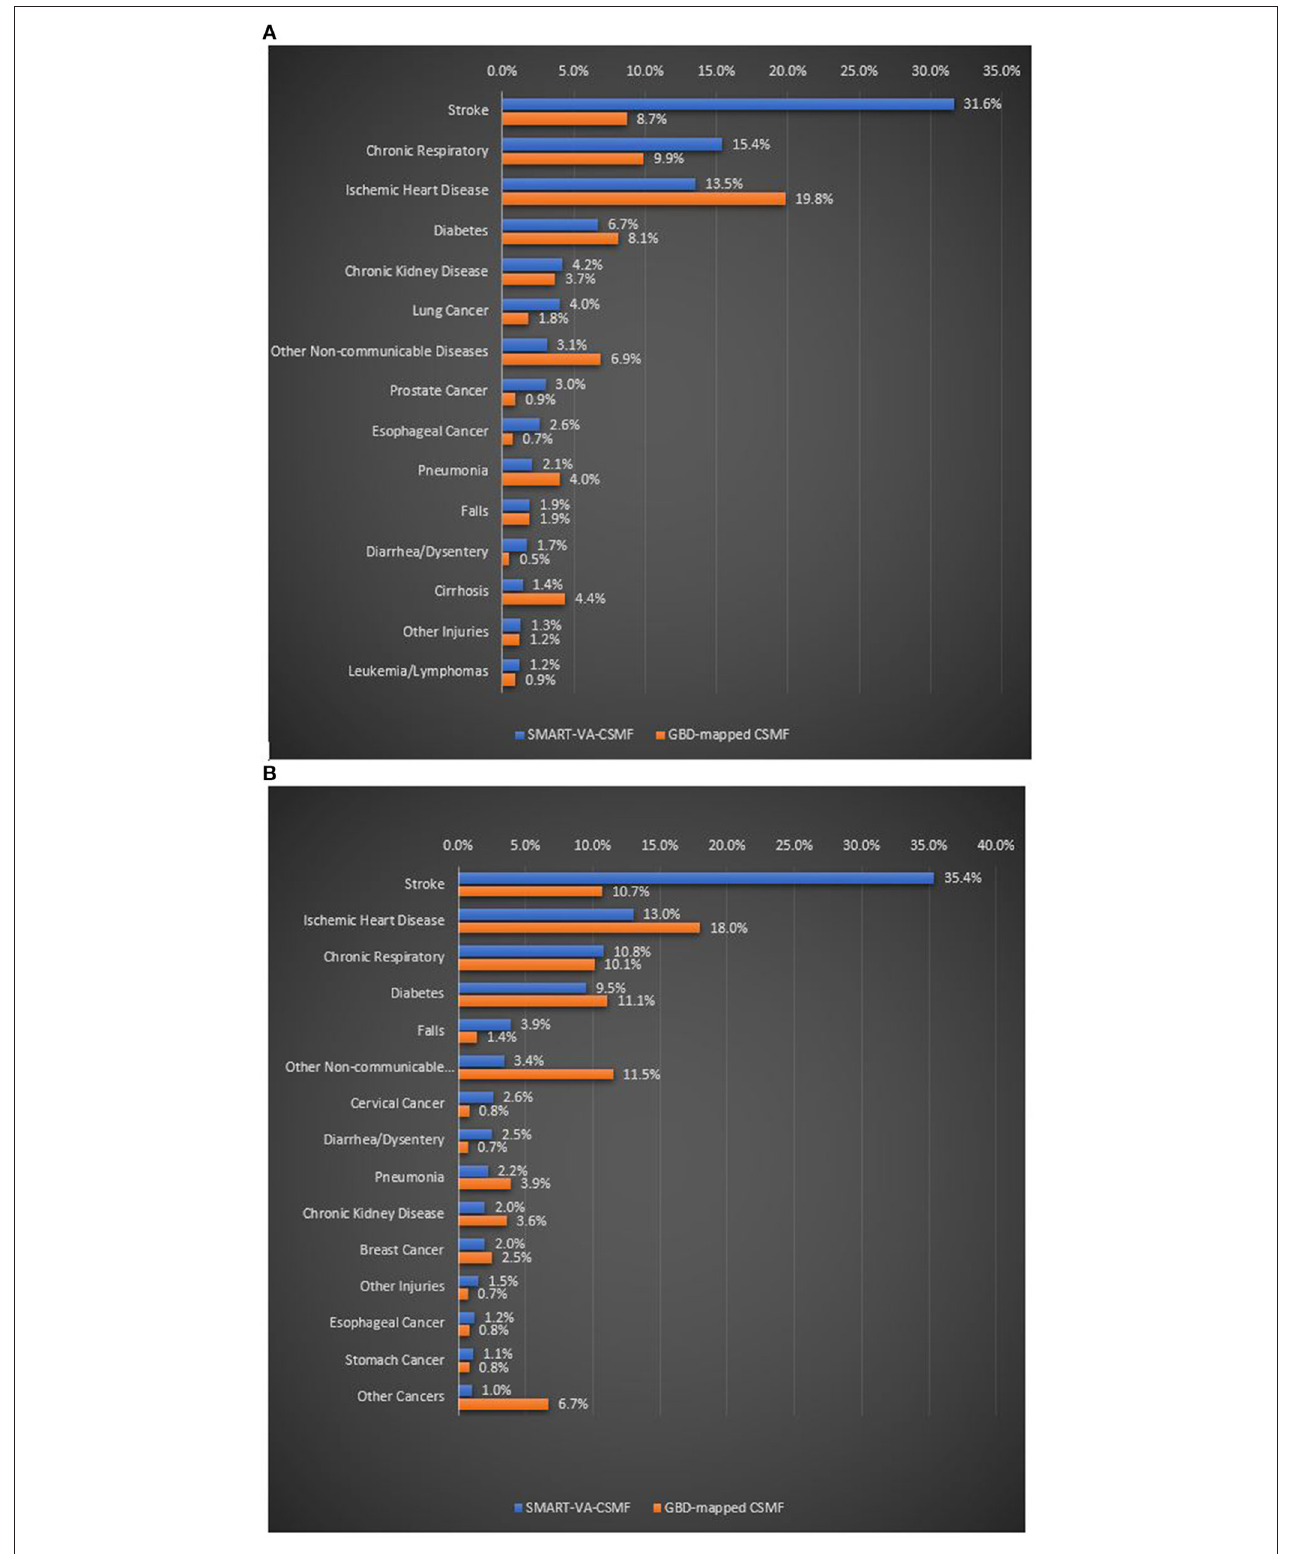
FIGURE 1 | (A) Leading 15 CSMFs for adult males estimated by SmartVA and the GBD, Sri Lanka, 2017–18. (B) Leading 15 CSMFs for adult females diagnosed by SmartVA and the GBD, Sri Lanka, 2017–18.